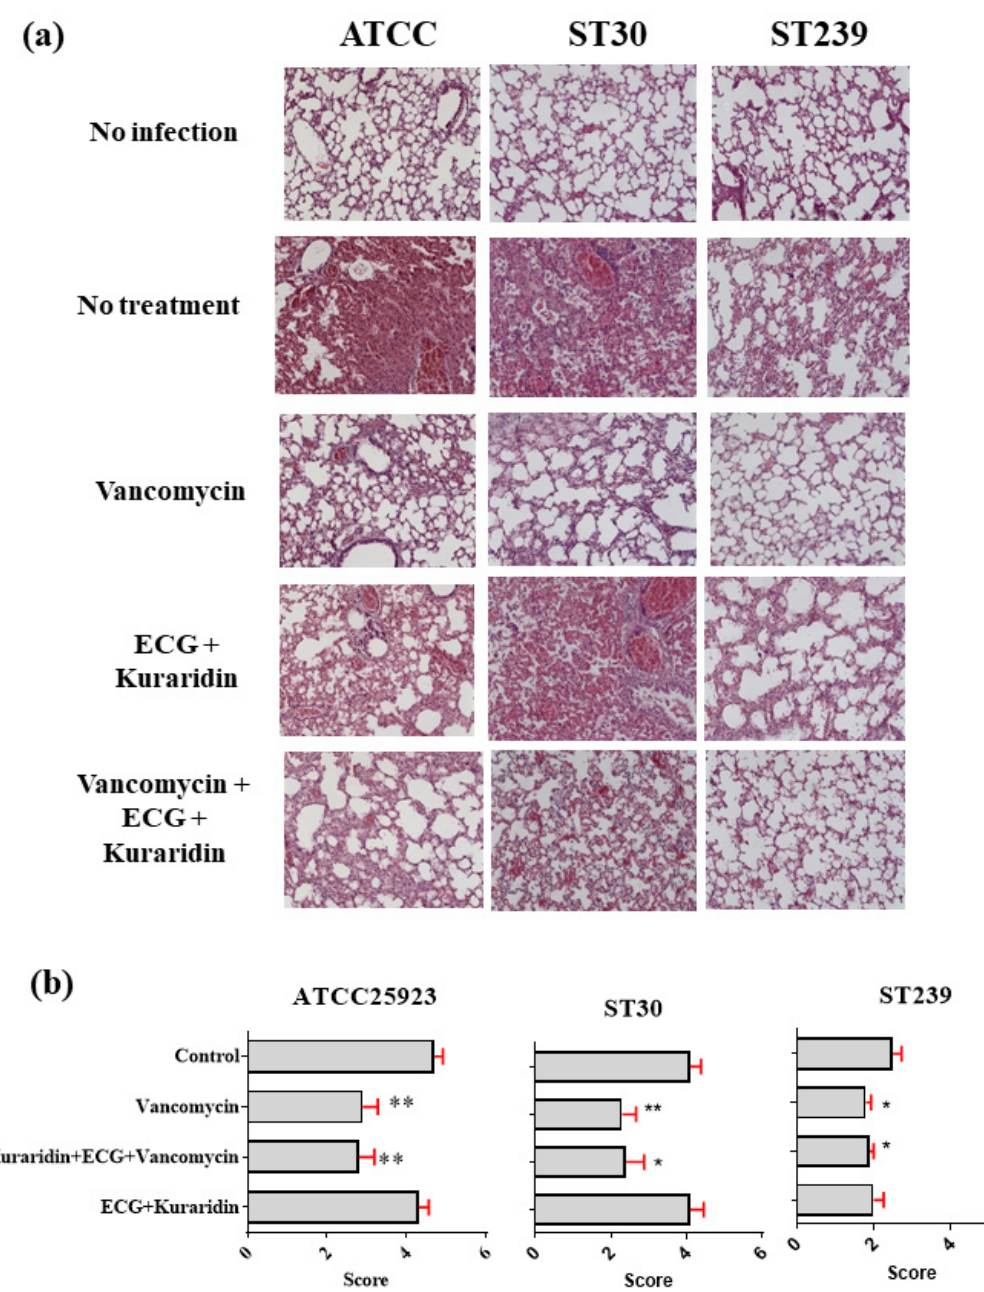
Figure 4. Mice infected with ATCC25923, ST239, or ST30 (3 × 10 8 colony forming unit (CFU)) with different treatment options. Mice were sacrificed after 48 h. ( a ) Histology of lung tissue in different groups; ( b ) the pneumonia scores of the right lung histology (n = 10). Significant results by comparing the drug treatment groups with the drug free control are indicated (* p < 0.05; ** p < 0.01 (n = 10). The bacterial counts and survival rates (Figure 3b) of vancomycin alone on